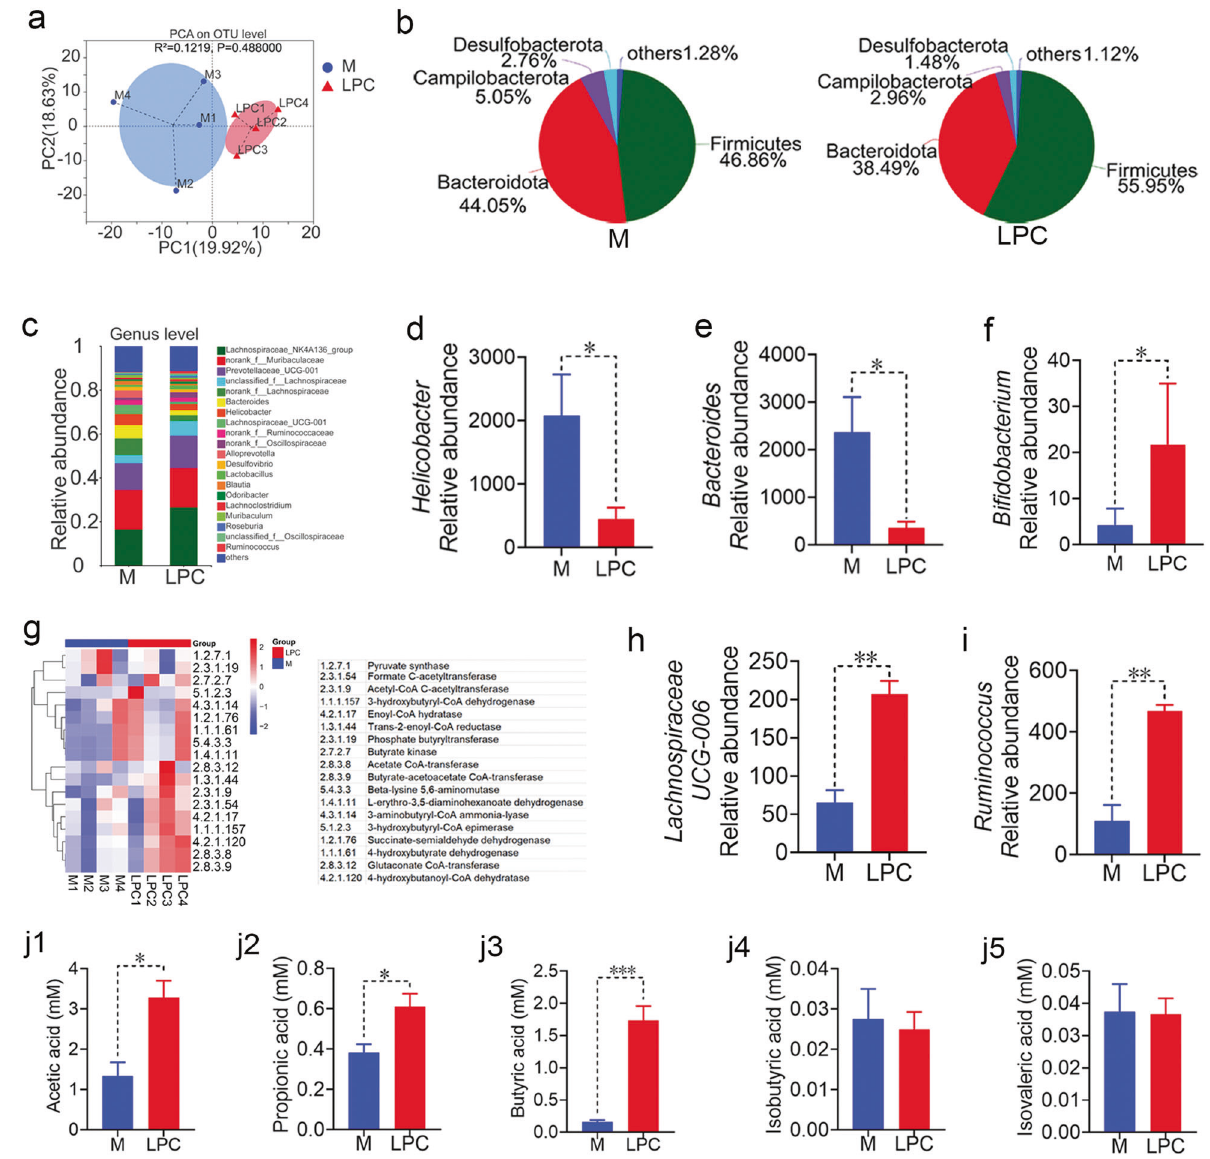
Fig. 5 LPC regulates gut microbiota and their metabolites in pulmonary metastatic mice. a PCA plot with Bray-Curtis distance analysis at OTU level. b Abundance of major bacterial phyla. c Abundance of major bacterial genus. d – f Relative abundance of Helicobacter , Bacteroides and Bi fi dobacterium ( n = 4 mice). g The gene copies of butyric acid synthesis related enzymes in each group ( n = 4 mice). h , i Relative abundance of Lachnospiraceae UCG-006 and Ruminococcus ( n = 4 mice). The levels of fecal SCFAs such as j1 acetic acid, j2 propionic acid, j3 butyric acid, j4 isobutyric acid and j5 isovaleric acid ( n = 4 mice). Data were presented as mean ± SEM, * p < 0.05, ** p < 0.01, *** p <